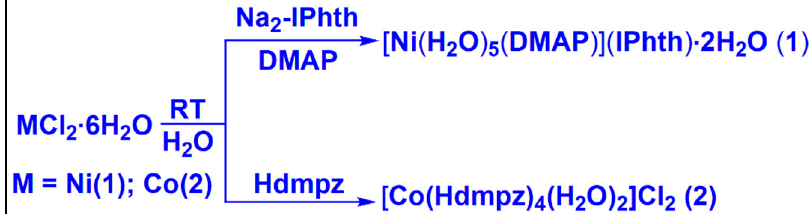
Table 1. Crystallographic data and structure refinement details for the compounds 1 and 2